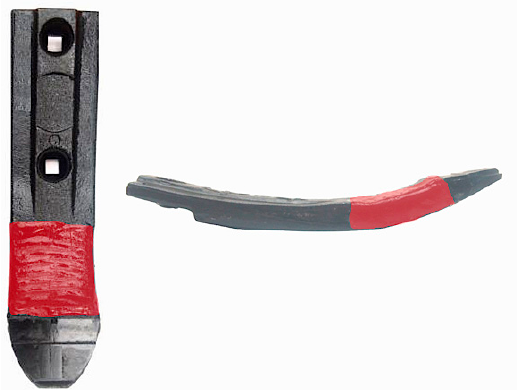
Figure 2. Location of the tested claddings produced by welding on the cultivator coulter.